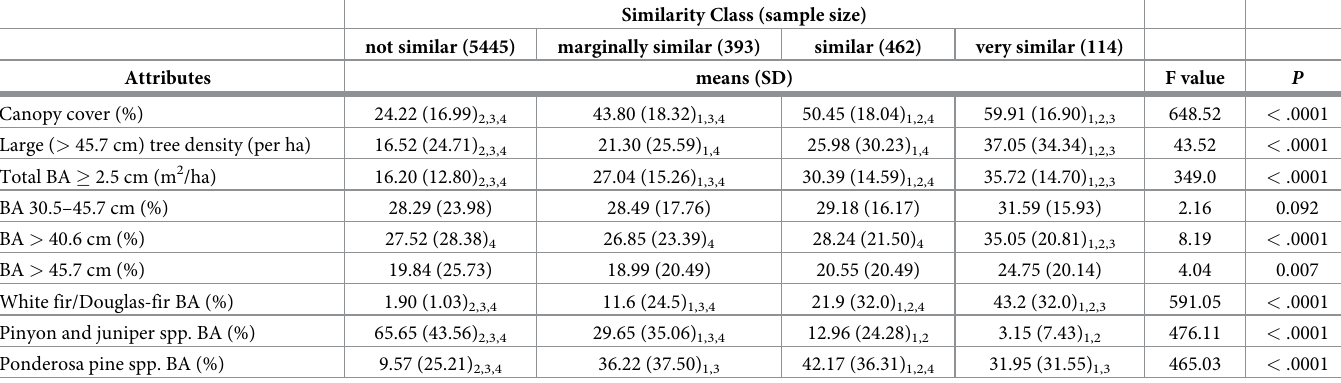
Table 2. Results of pairwise comparisons between structural and compositional attributes and similarity class.